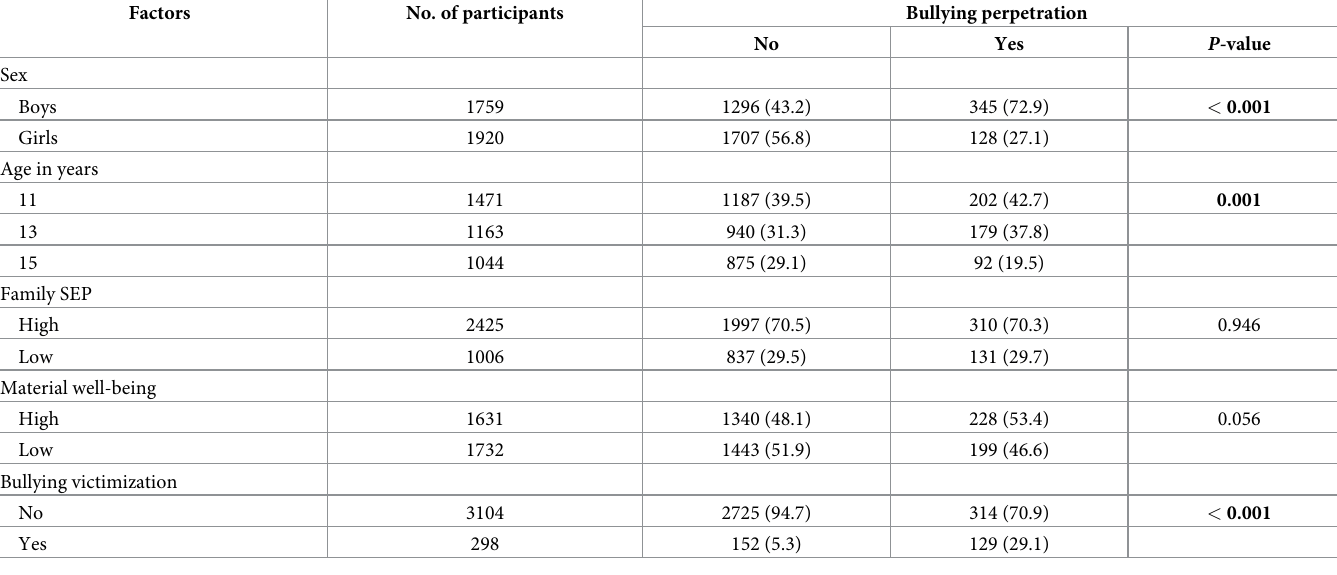
Table 1. Frequencies (percentages) of adolescent characteristics by bullying perpetration (n = 3679 participants a ). Factors